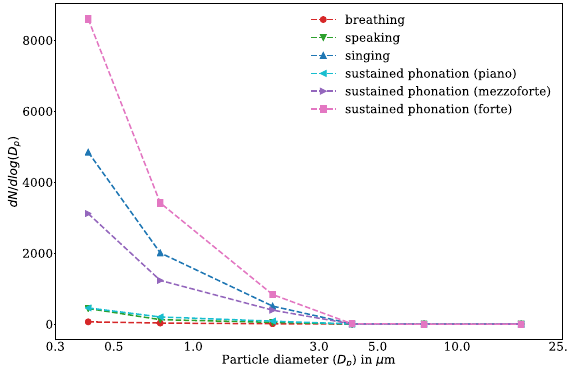
Figure 1. Normalized emission rates for all test conditions according to the legend. Data were averaged across all eight participants and all five replicants for each test condition. Marker positions are at the mean of the particle diameter of each size class on the linear scale (see “Methods” section). Regardless of the test condition, > 99 % of all detected particles are ≤ 5 µm. The terminology, piano, mezzo-forte, and forte describes singers’ loudness conditions, namely soft, medium, and loud phonation. (Figure created with matplotlib 3.2.1, http:// matpl otlib. org).